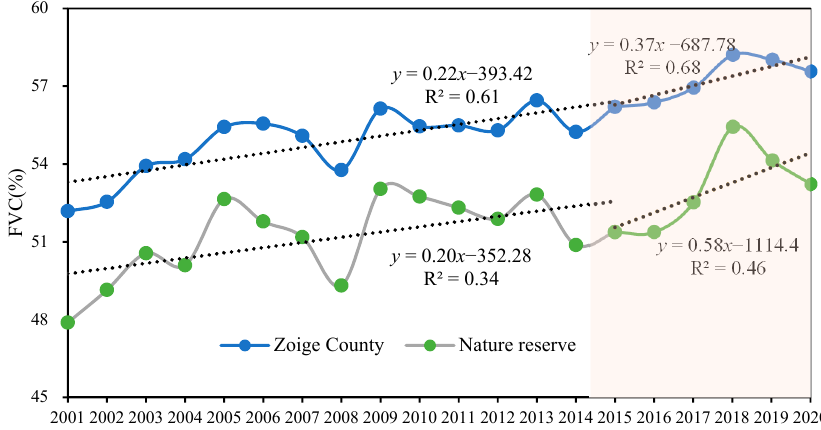
Figure 3. Interannual variation in fractional vegetation cover (FVC) in Zoige county and the nature reserve from 2001 to 2020.